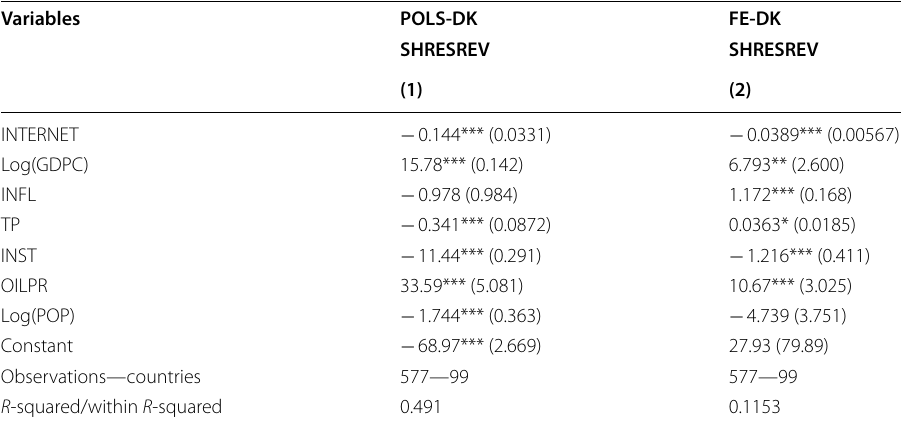
Table 1 Impact of the Internet usage intensity on the share (%) of resource revenue in total resource revenue. Estimator : POLS-DK and